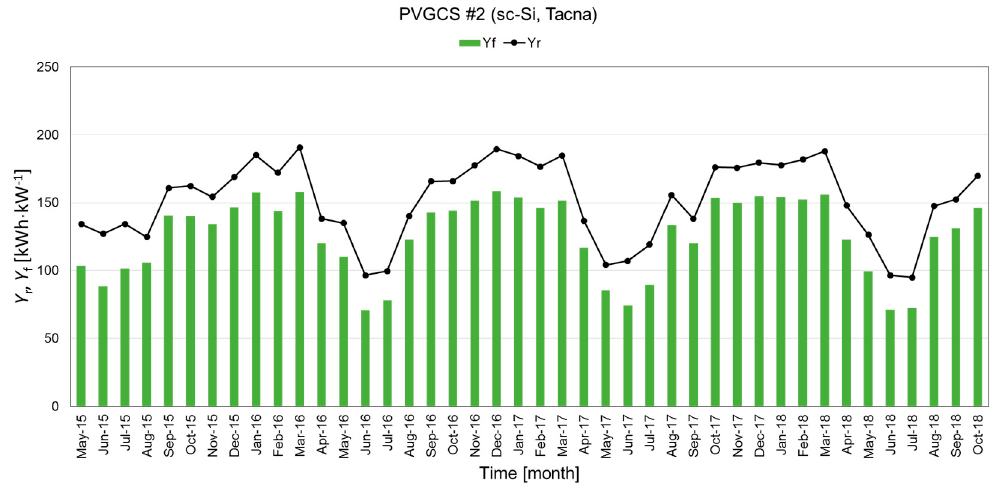
Figure 3. Values of Y r and Y f for PVGCS #2 over the period under scrutiny. Both the PV field and PVRD were left unclean.